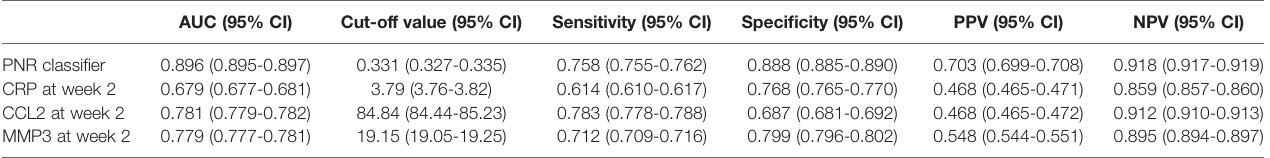
TABLE 4 | The ability of PNR classi fi er in predicting primary non-response to IFX. AUC (95%